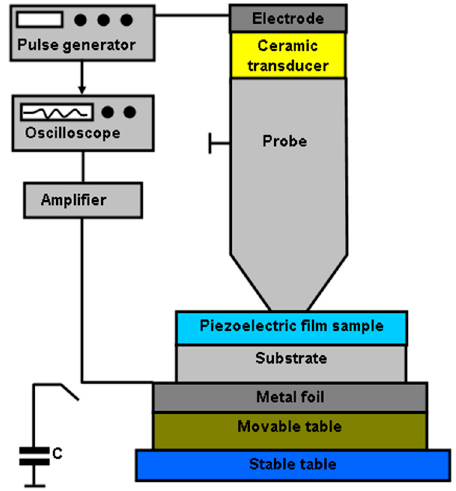
Figure 1. Acoustic probe used for piezoelectric component d 33